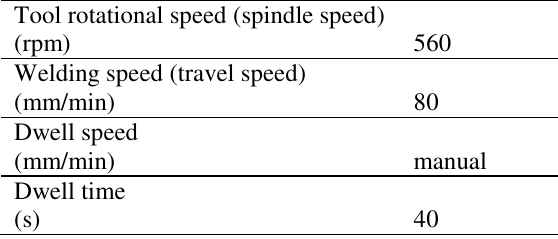
Fig. 3. Fixing framework. Table 4, Used Bobbin friction stir welding process